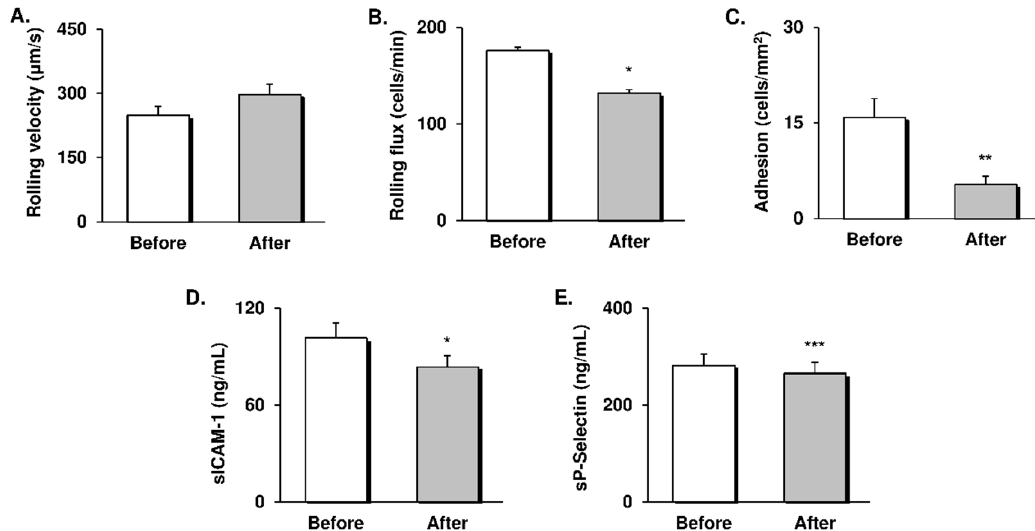
Figure 2. Evaluation of leukocyte-endothelial cell interactions and serum levels of CAMs in obese patients before and 12 months after RYGB intervention. ( A ) Rolling flux, measured as cells per minute ( n = 24). ( B ) Leukocyte rolling velocity, expressed as µ m / s ( n = 24). ( C ) Leukocyte adhesion, expressed as cells / mm 2 ( n = 24). Serum levels of ( D ) sICAM-1 ( n = 46) and ( E ) sP-selectin ( n = 46). Data are represented as the mean + SE. * p < 0.05, ** p < 0.01, *** p < 0.001 when compared using a paired Student’s t-test. CAMs: Cellular adhesion molecules; RYGB: Roux-en-Y gastric bypass; sICAM-1: Soluble intracellular adhesion molecule; sP-selectin: Soluble platelet selectin.